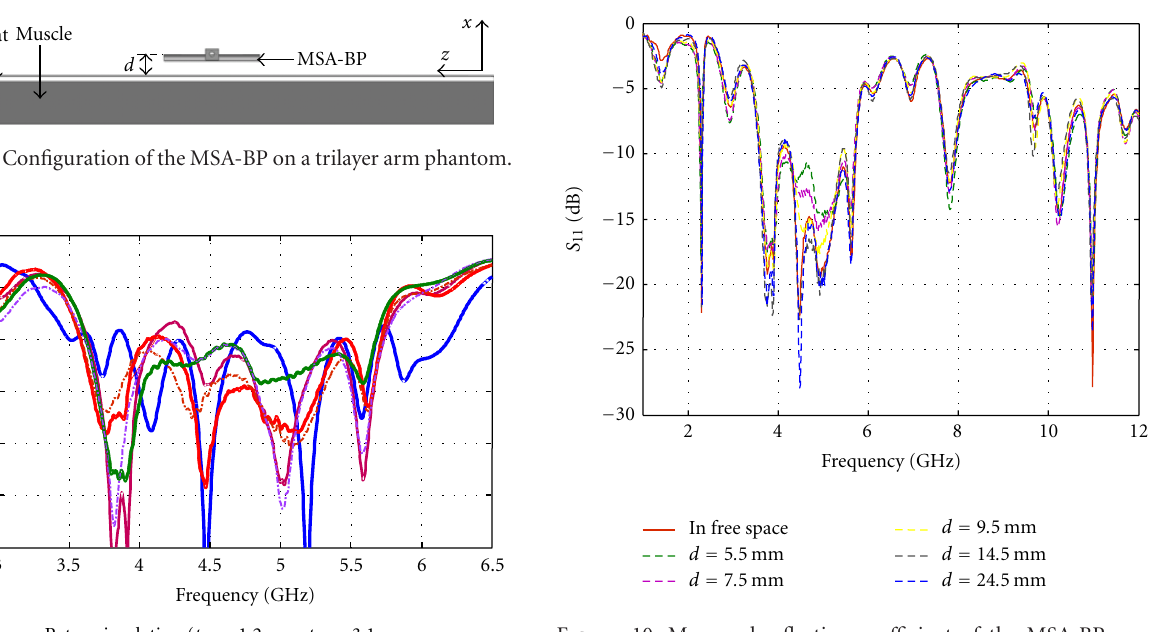
Figure 10: Measured reflection coe ffi cient of the MSA-BP on a human subject for di ff erent values of the separation distance d . Table 2: Radiation e ffi ciency of the MSA-BP and the reference